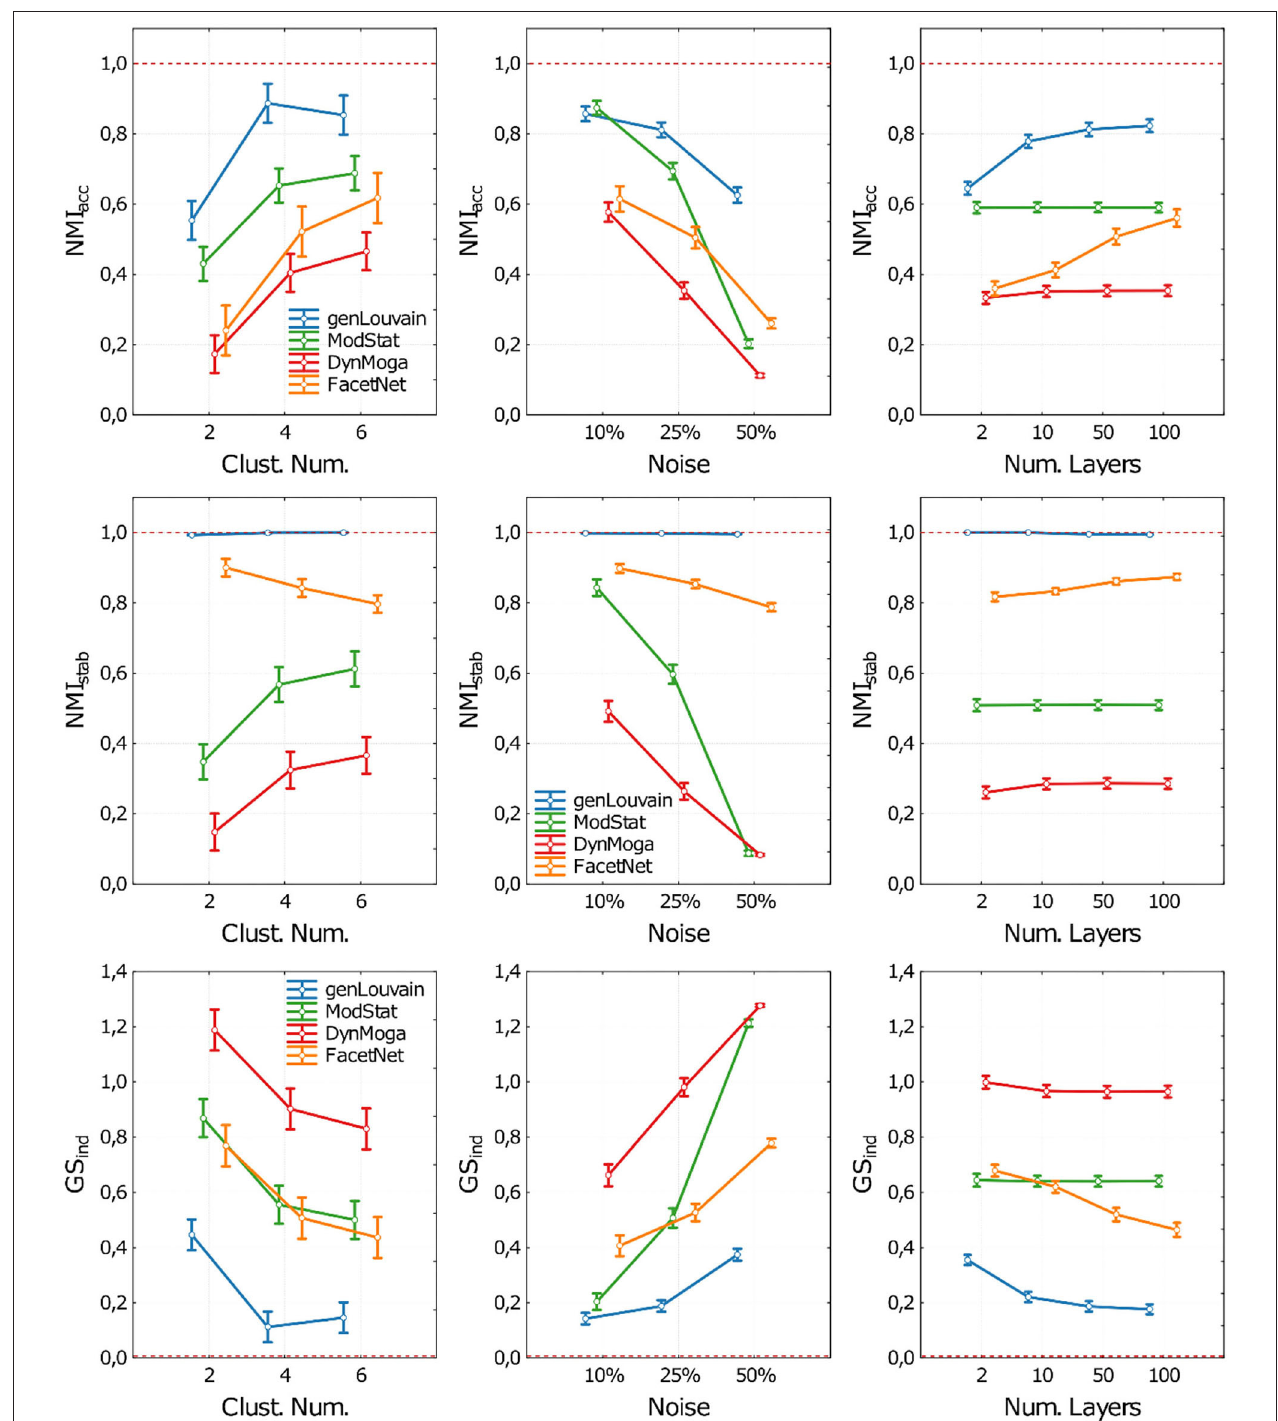
FIGURE 3 | Plot of means and standard deviations of the three indices used to execute the comparative analysis on networks with stationary community structure. Each row of the figure corresponds to one index (NMI acc , NMI stab , GS ind ). For each index we report three panels where we show the algorithms’ performances with respect to the Clusters Number (first column), Noise level (second column), and number of network’s layer (third column). Algorithms are identified through a color code (blue-genLouvain, green-ModStat, red-DynMoga, orange-FacetNet). In each panel we can see how the performance of the algorithms varies according the values the ANOVA factors and which algorithm reaches highest performances, in terms of accuracy (NMI acc ), stability (NMI stab ) or both (GS ind ). The optimal performances are indicated though a red dotted line.